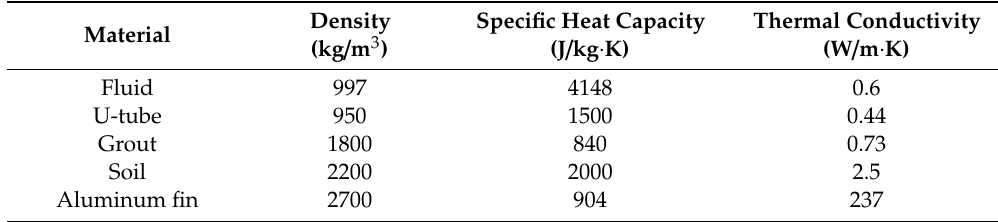
Table 4. Physical properties of materials.